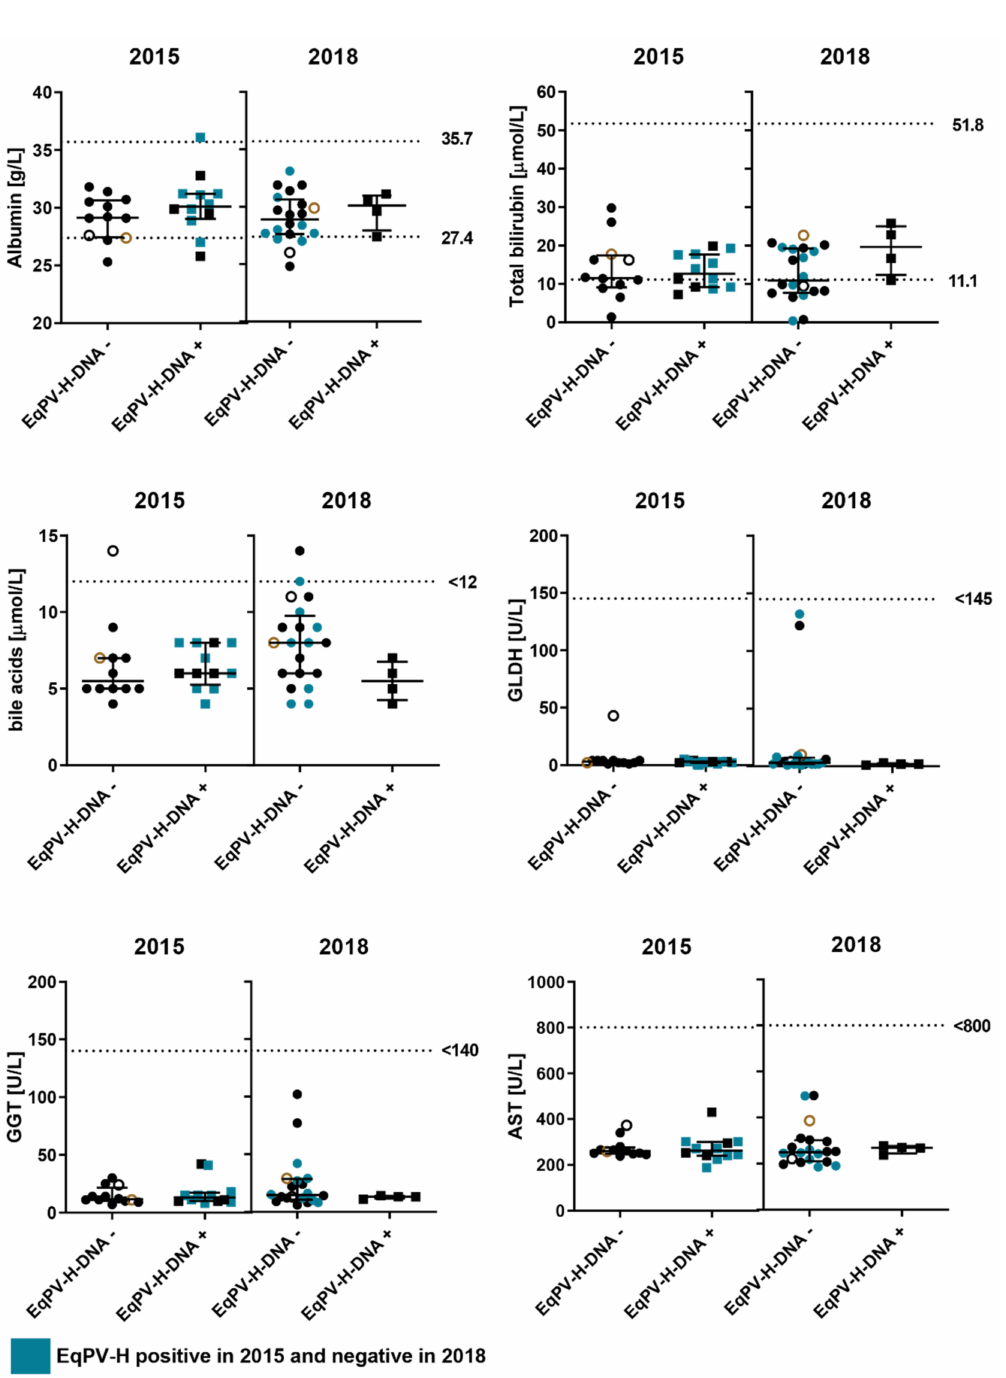
Figure 3. Liver specific biochemical analytes. Serum samples of 24 horses were used to determine their liver specific analytes in 2015 and 2018. Two groups divide horses depending on their qPCR result for EqPV-H. Horses are highlighted in blue if their qPCR result changed from samples taken in 2015 and 2018. Six analytes were measured and are shown: Albumin in grams/Liter (g/L) reference ranges between 27.4–35.7 g/L, total bilirubin in µ mol/L; reference ranges between 11.1–51.8 µ mol/L, bile acids in µ mol/L; reference range is <12 µ mol/L, glutamate dehydrogenase (GLDH) in units/Liter (U/L); reference range is <145, gamma-glutamyltransferase (GGT) in U/L; reference range is <140 and aspartate aminotrans- ferase in U/L reference range is <800. Dotted line in each graph represents the corresponding standard cut-offs. Central tendency and variation are presented as median and interquartile ranges. Brown and black cycles indicate hepacivirus positive horses 56 and 61, respectively. Performing a 2-way ANOVA followed by Š í d á k’s multiple comparisons test, no significant differences between EqPV-H positive and negative samples were